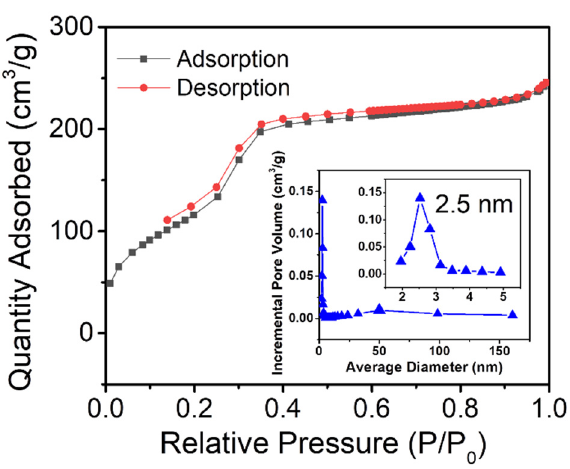
Figure 3. N 2 adsorption/desorption isotherms of uf-P@m-SiO 2 with their average pore width versus incremental pore volume, determined via the BJH method by desorption isotherms.